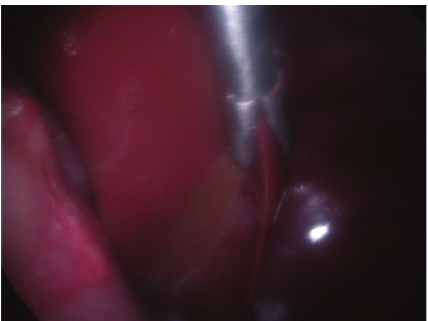
Figure 12: Laparoscopic procurement of liver biopsy (right flank approach) depicting oval biopsy forceps grasping the hepatic nod- ule at the edge of right medial liver lobe in 7-year-old male mixed- breed dog with hepatic nodular hyperplasia and radiographic appreciation of pulmonary